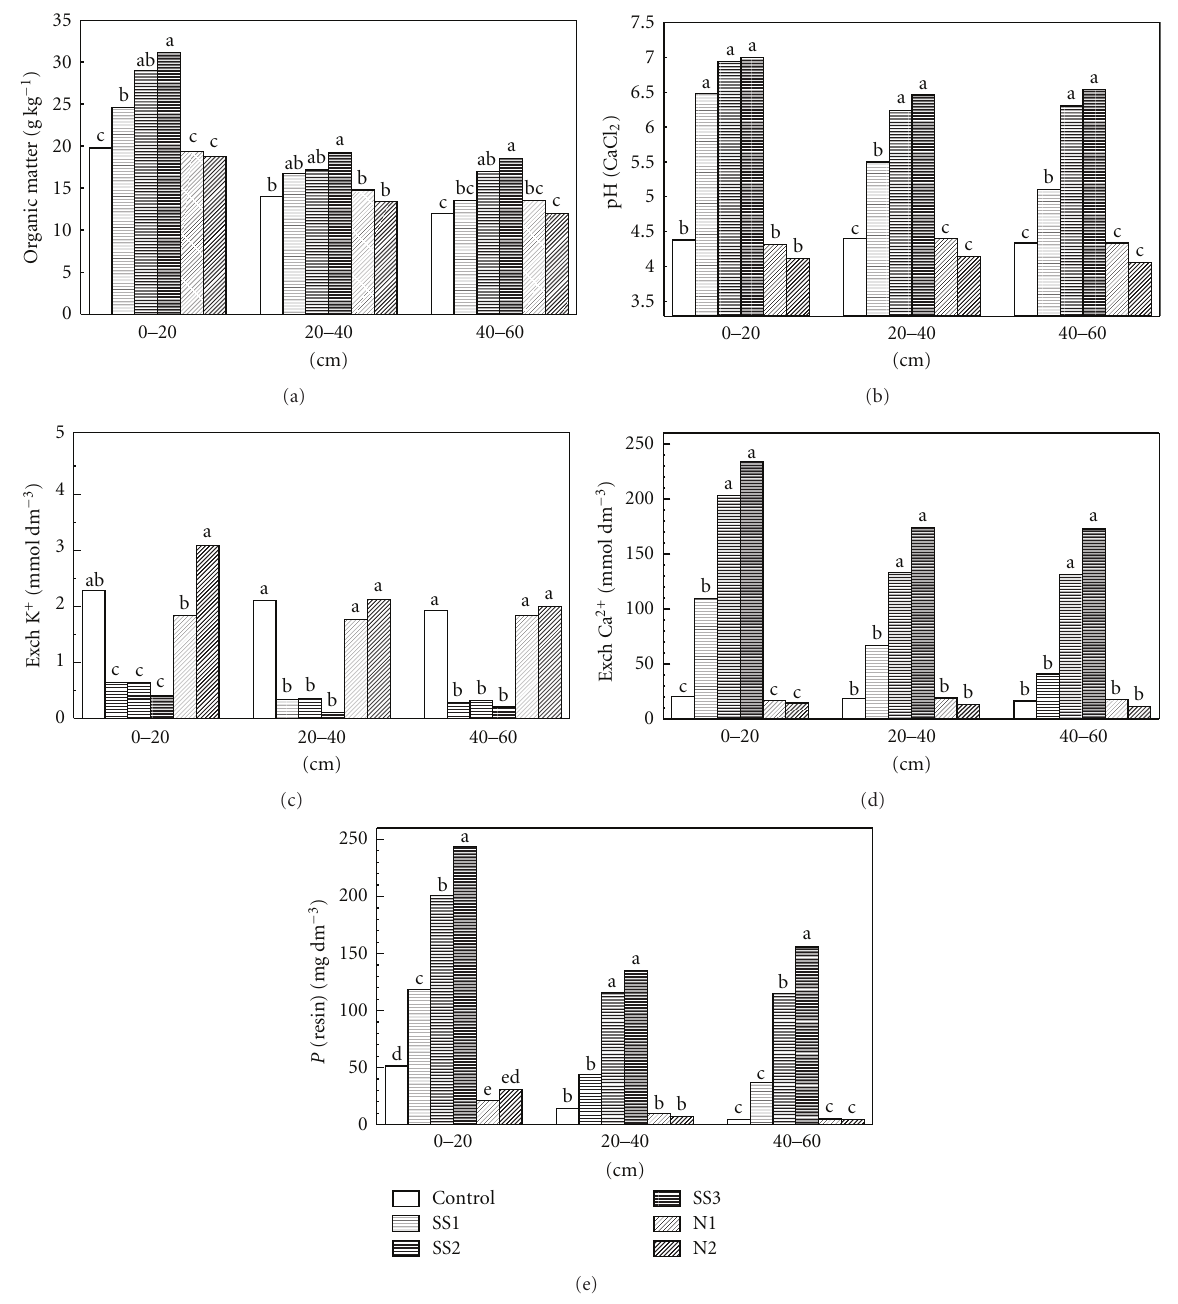
Figure 1: Soil chemical attributes in plots treated with biosolids (SS) and mineral N fertilizer (N) in three di ff erent soil depths. Columns with the same letters indicate that values do not di ff er by the Student’s t -test ( P > . 05).